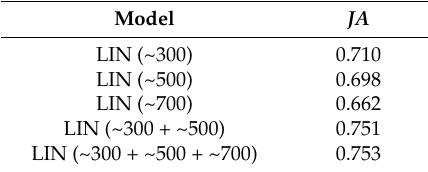
Table 4. JA of frameworks with different scales of inputs.